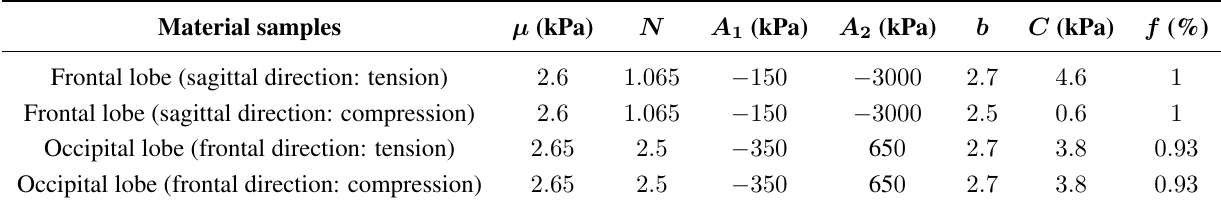
Table 3. Material constants used to fit the brain tissue experimental data. Material samples